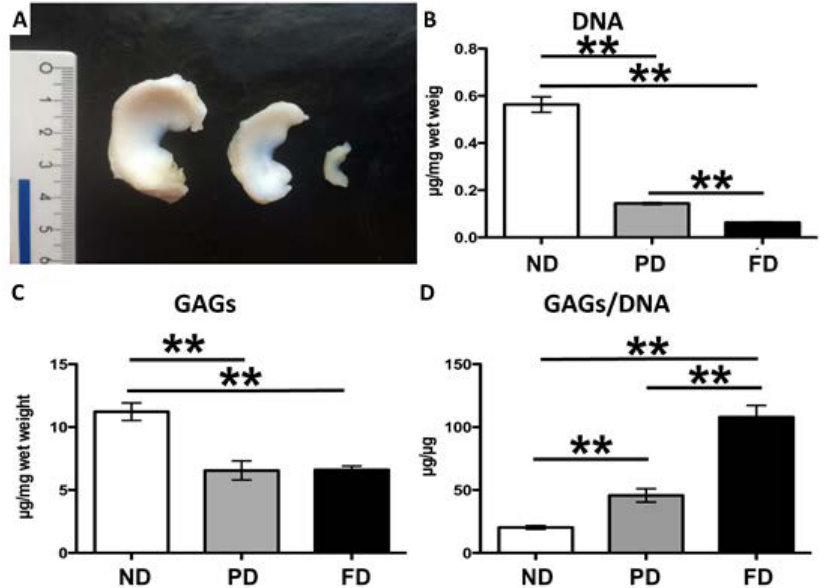
Figure 1. ( A ) Macroscopic aspect and comparison of menisci belonging to the three classes of age. ( B – D ) Differences in biochemical analyses of menisci belonging to the three classes of age: ( B ) DNA quantification; ( C ) GAGs quantification; ( D ) GAGs/DNA ratio. Quantification of DNA normalized to the wet weight ( µ g/mg). Values with ** differ for p <